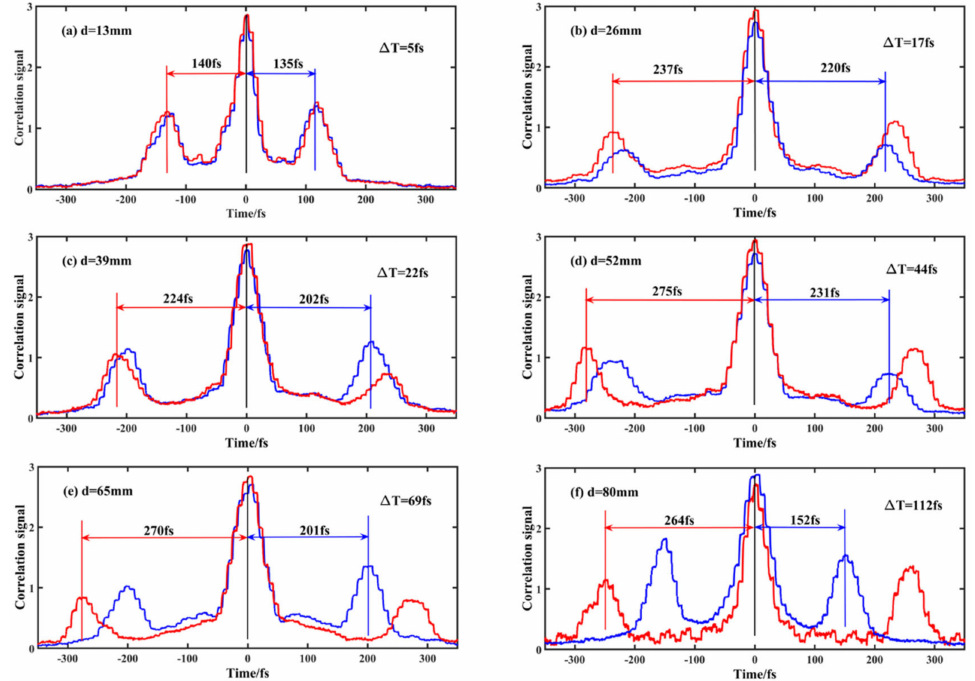
Figure 3. Measured correlation signals of the six sampled